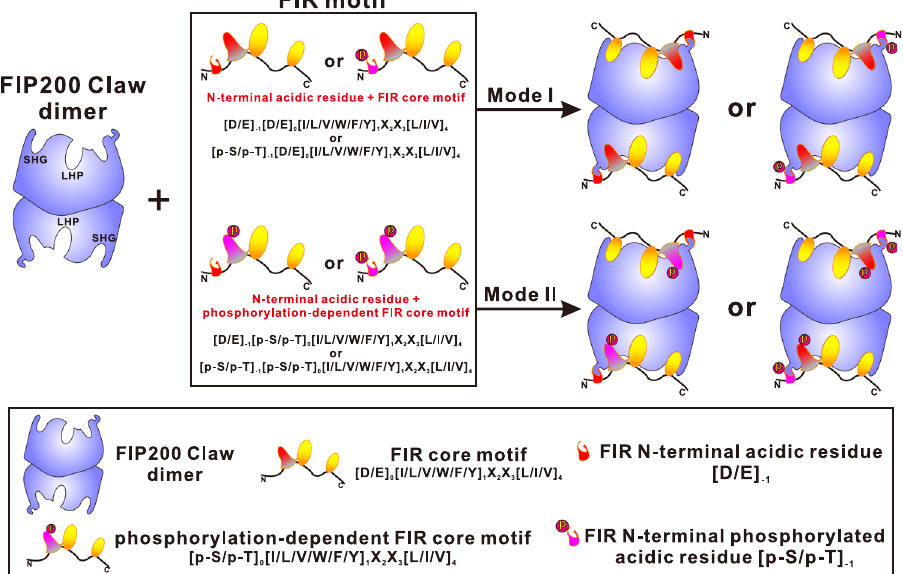
Fig. 5 A schematic cartoon diagram summarizing the two different binding modes of FIR motifs in interacting with the FIP200 Claw domain. In this diagram, “ LHP ” stands for the large hydrophobic pocket of FIP200 Claw formed by the side chains of C1565, A1567, F1574, V1576, and F1582 from FIP200, and “ SHG ” stands for the small hydrophobic groove of FIP200 Claw formed by the side chains of FIP200 Y1564 and